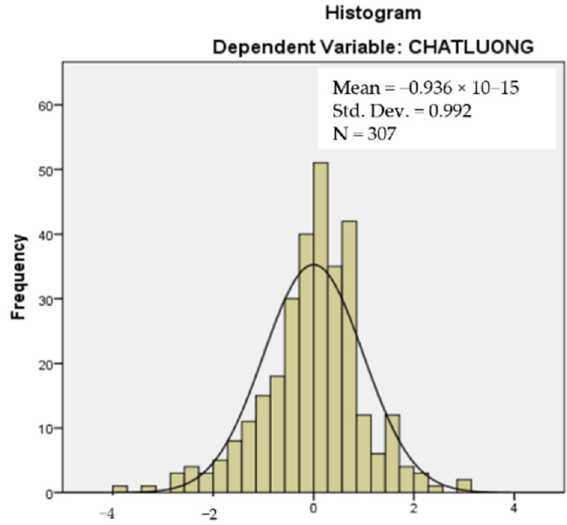
Figure 3. Regression standardized residual.